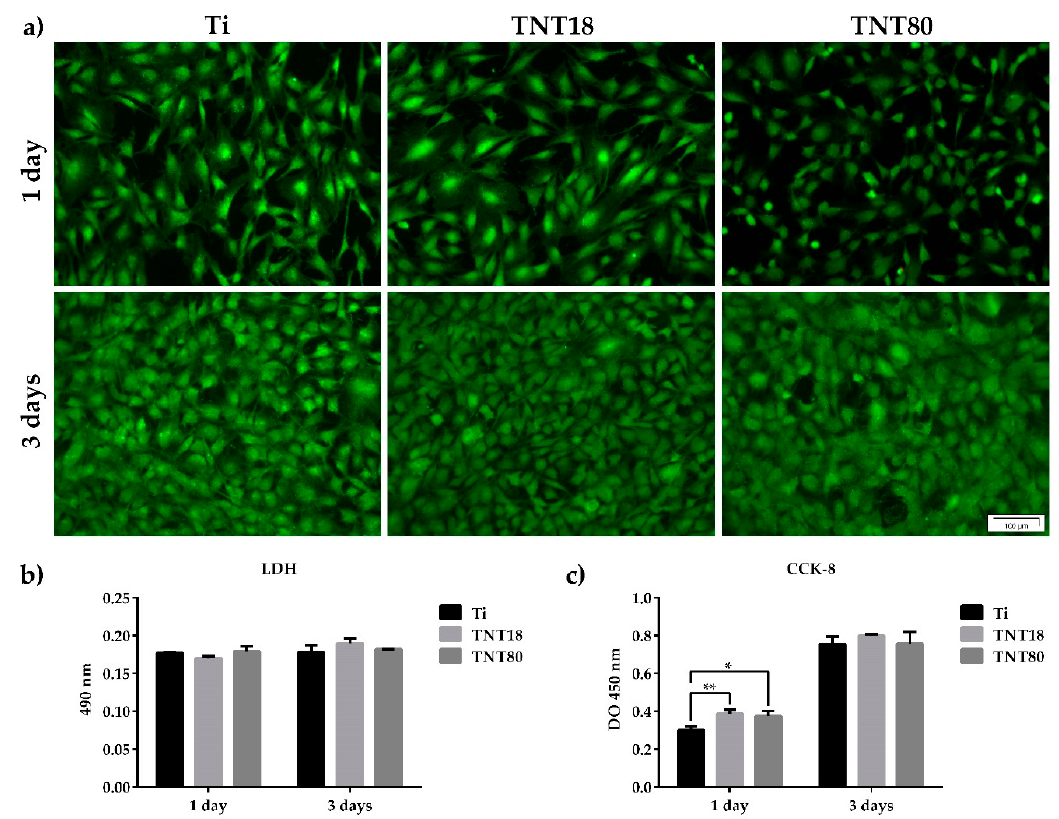
Figure 2. MC3T3-E1 pre-osteoblast survival and proliferation status. ( a ) Fluorescence images indicating the exclusive presence of green-labeled viable cells on all tested surfaces after staining with LIVE/DEAD Viability/Cytotoxicity kit; ( b ) The lactate dehydrogenase (LDH) levels released in the culture medium by cells grown in contact with Ti, TNT18 and TNT80 surfaces (n = 3, mean ± SD); ( c ) Pre-osteoblast proliferation capacity as evaluated by CCK-8 assay (n = 3, mean ± SD, * p < 0.05, ** p < 0.01 vs. Ti).